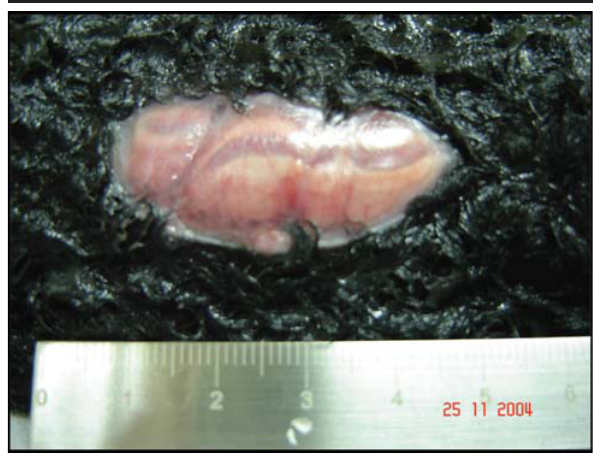
FIGURA 2 - Postnatal macroscopic aspect of the spinal defect at 139 days of gestation. Note the opened skin and the exposed medulla